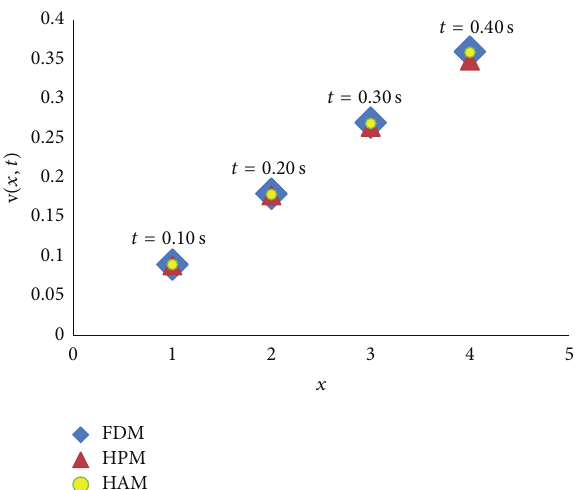
Figure5:ThecomparisonofHPM,HAM,andFDMforthesolution V (𝑥,𝑡) for different values of 0 ≤ 𝑥 ≥ 4 and 0 ≤ 𝑡 ≥ 0.4 ; ℏ = 0.001 .